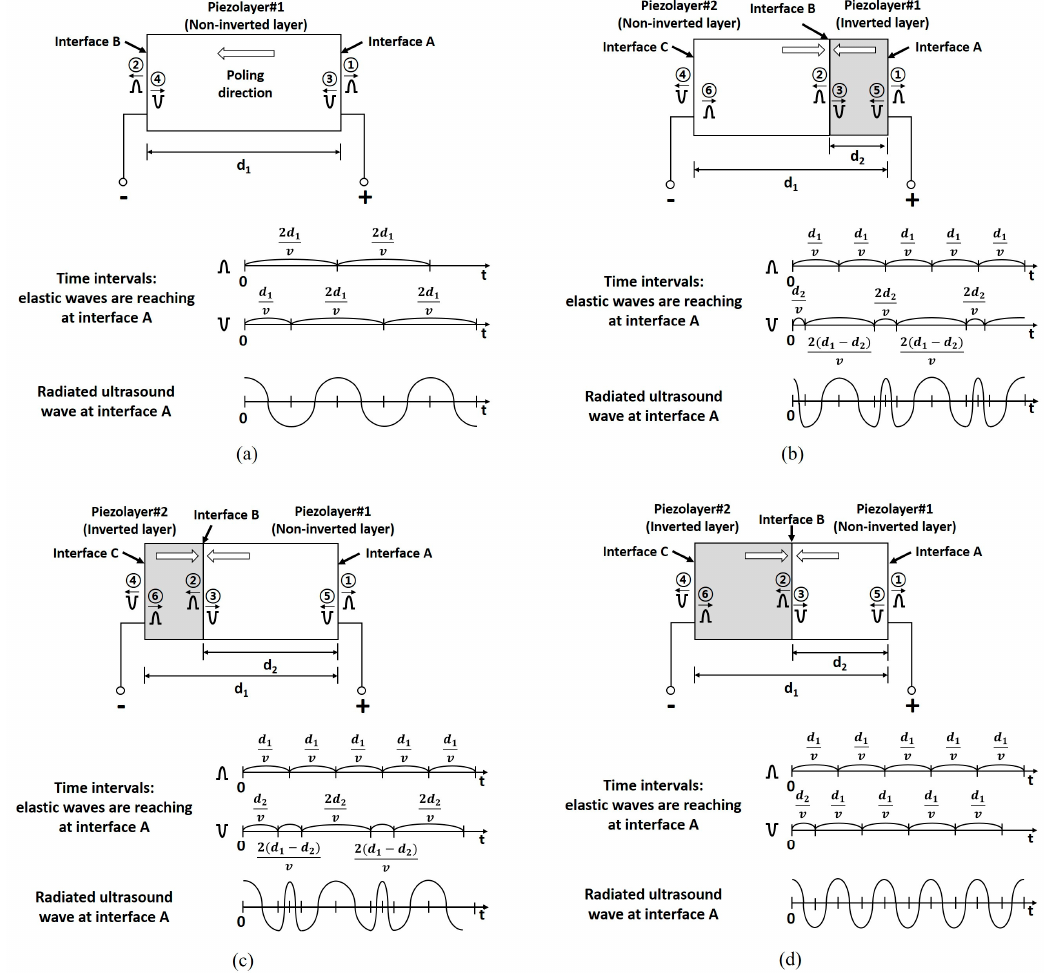
Figure 1. Operational principle of the conventional and polarization inversion technique (PIT) models: ( a ) Conventional structure with a single piezoelectric layer, ( b ) polarization-inverted layer structure with a 0.25 inversion ratio (front-side inversion model), ( c ) polarization-inverted layer structure with a 0.25 inversion ratio (back-side inversion model), and ( d ) the PIT with a 0.5 inversion ratio (half-inversion model). Note that the time and frequency responses of the radiated ultrasound waves at interface A for each case were also demonstrated by computational simulation, as shown in Figure 2.